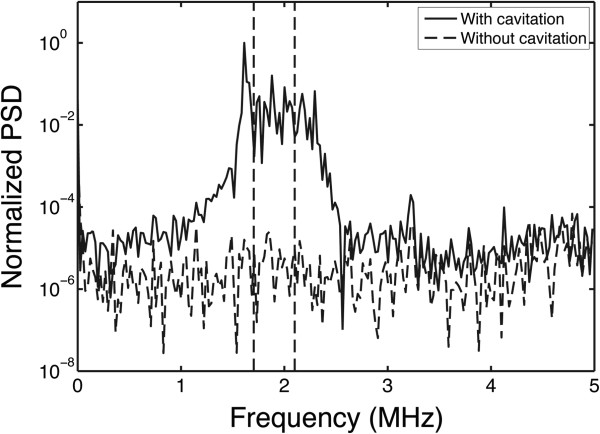
A typical example of normalized PSD in gel phantom with vaporized and unvaporized PSNE. The solid line represents the signal with vaporized PSNE, and the dashed line indicates the signal with unvaporized PSNE. The increase in broadband emissions around 2 MHz indicates the presence of inertial cavitation activity. Power density was integrated between 1.7 and 2.1 MHz and used as the IC dose of that segment. This frequency range was chosen due to the bandwidth of the 2-MHz PCD and to minimize the contribution from energy at the 1.6-MHz subharmonic peak.